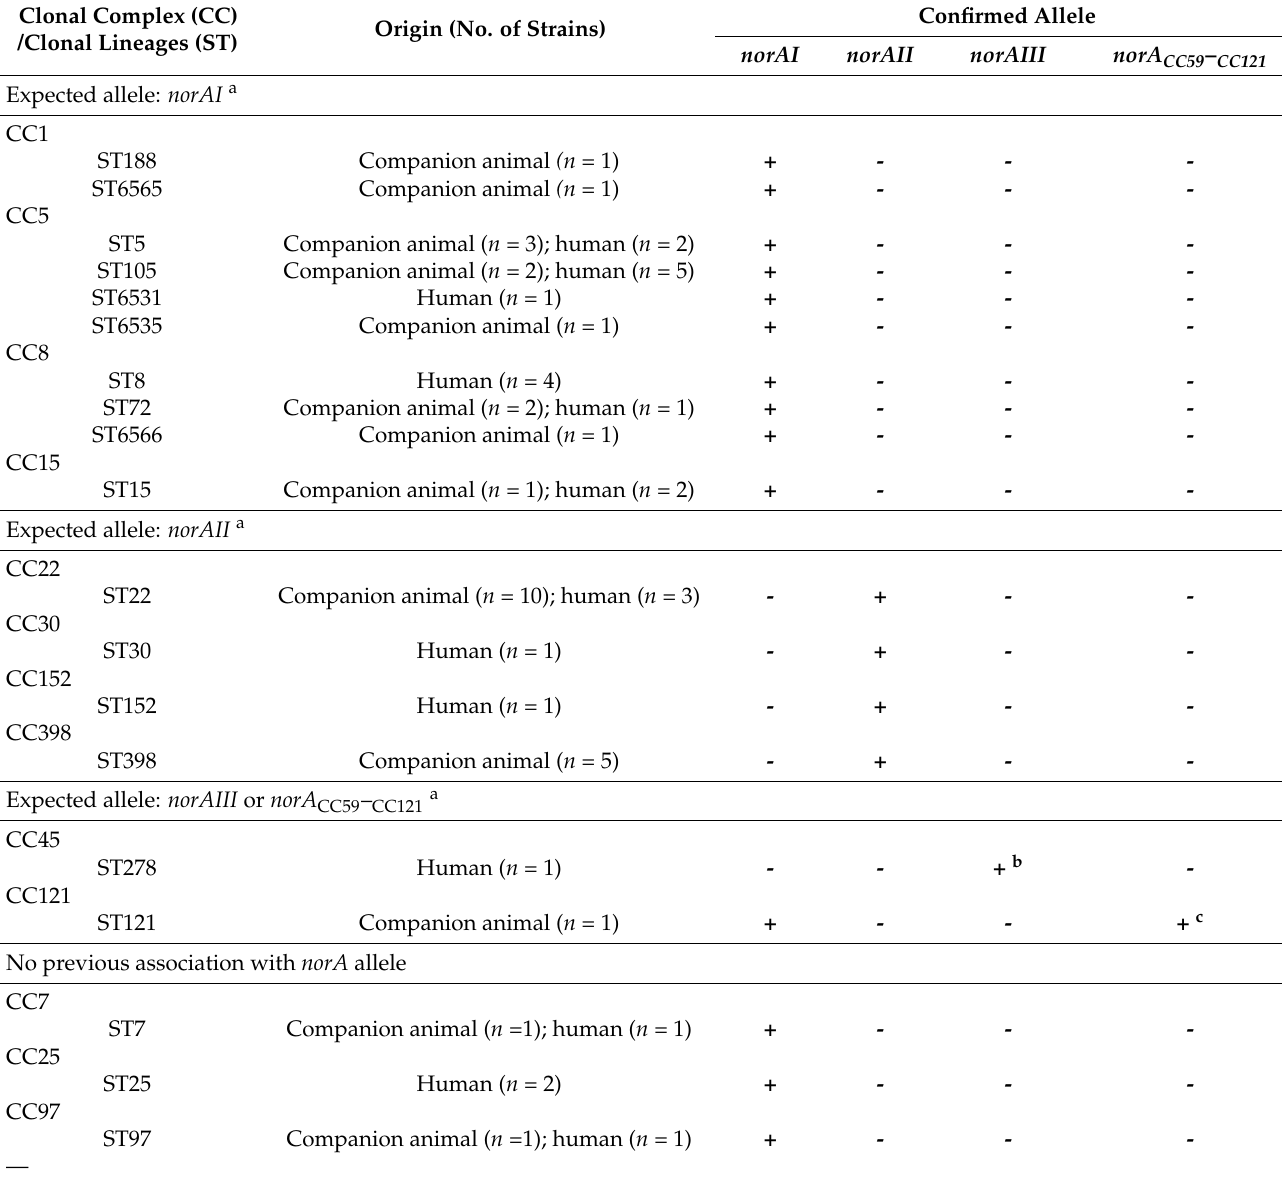
Table 2. Assignment of norA allele according to the lineage of the 52 S. aureus strains in study. Clonal Complex (CC) /Clonal Lineages